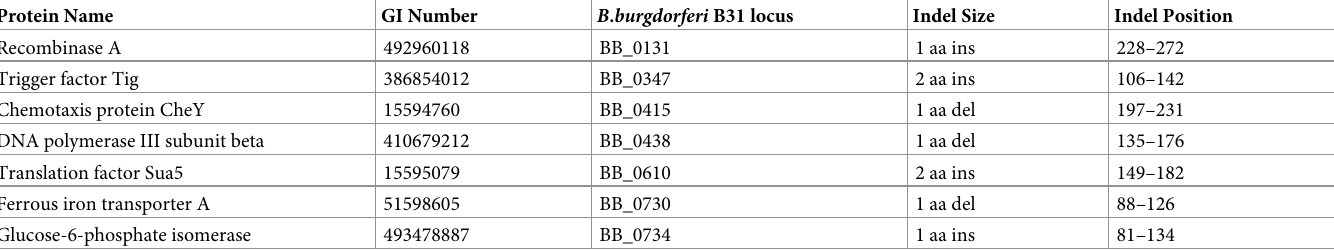
Table 1. Conserved signature indels (CSIs) found in widely distributed proteins that are specific for the members of the Lyme disease Borrelia (i.e. genus Borreliella